Question: Which kind of chart has been used to present this data?
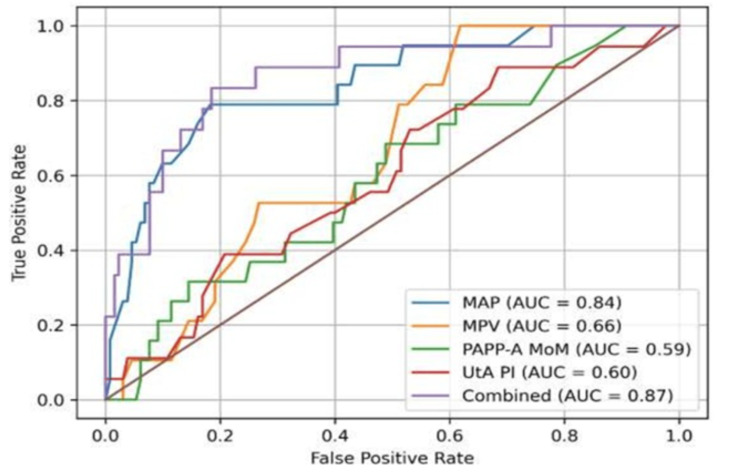
Answer: line